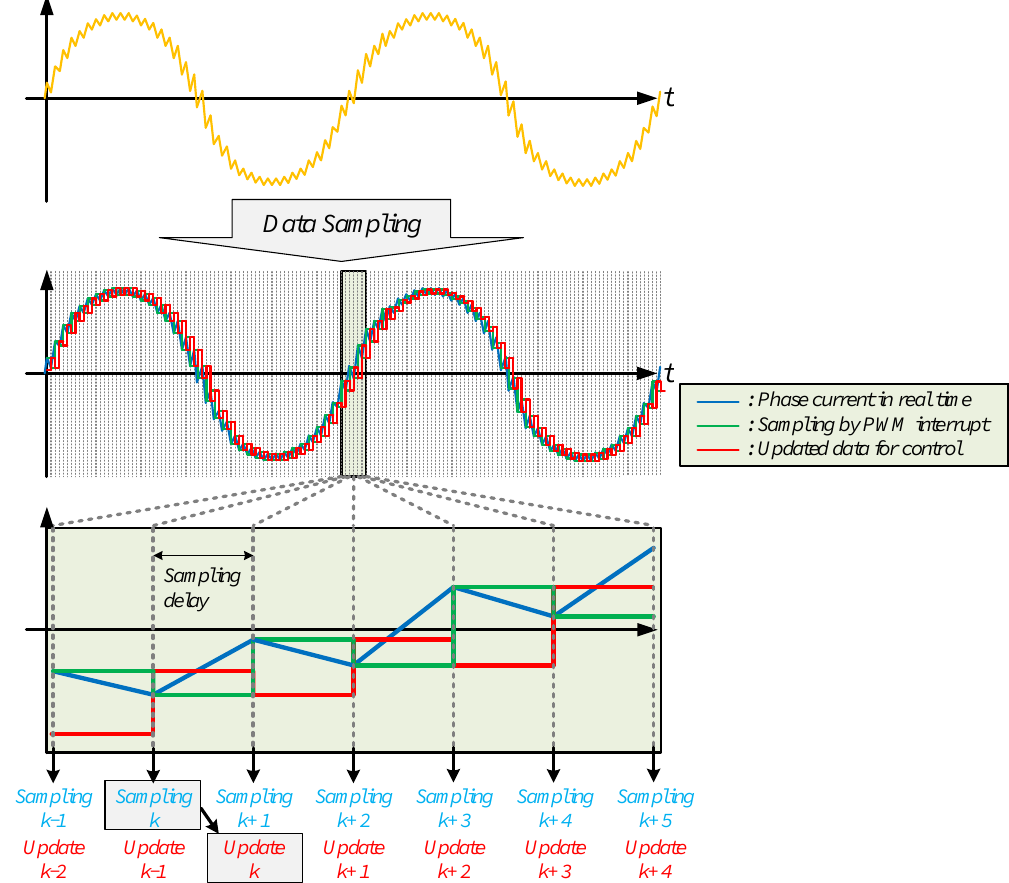
Figure 12. Sampling delay caused by analog-to-digital converter (ADC) module in a microcontroller unit (MCU).